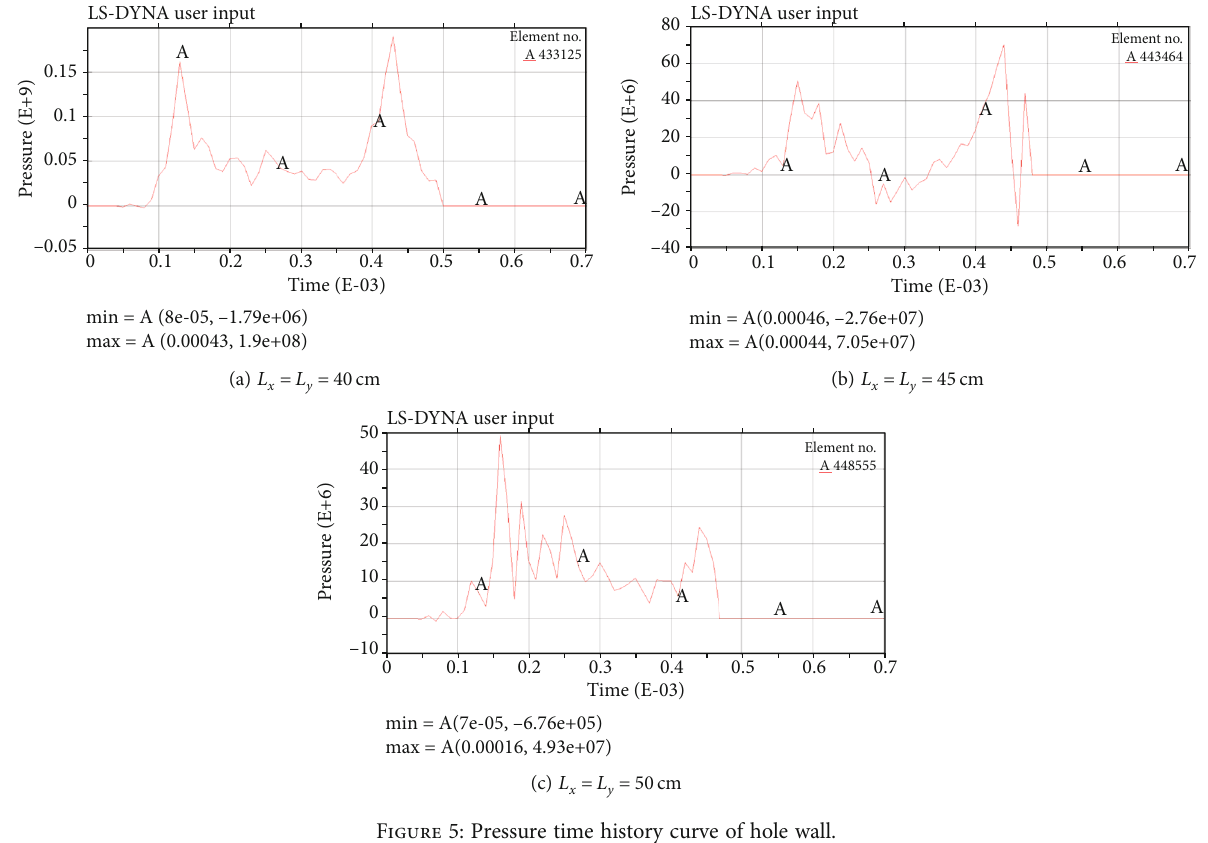
Figure 5: Pressure time history curve of hole wall.